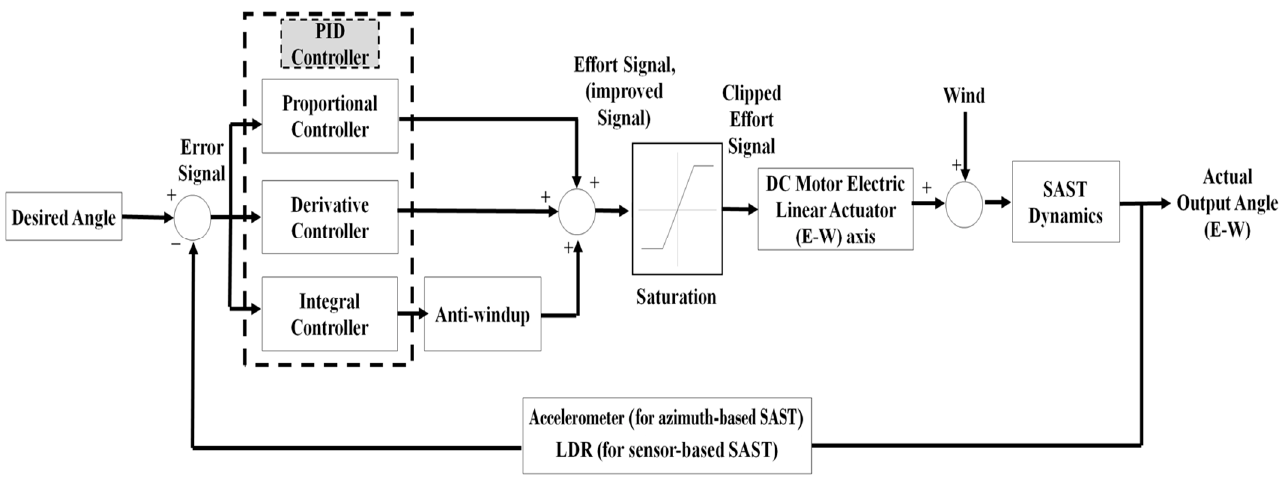
Figure 5. Control block diagram.